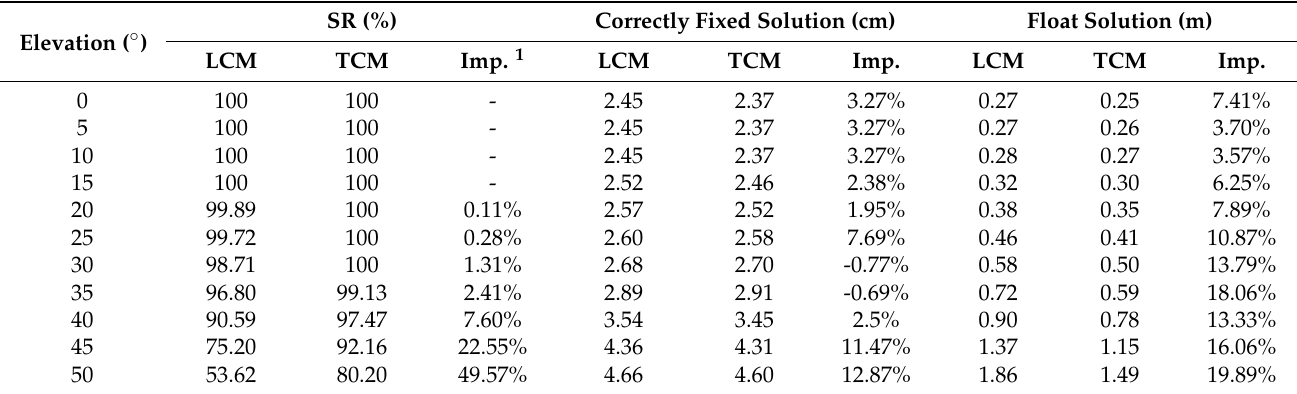
Table 5. The SR, accuracy of both the correctly fixed and float solutions of LCM and TCM RTK, and the corresponding improvement in TCM RTK with respect to LCM